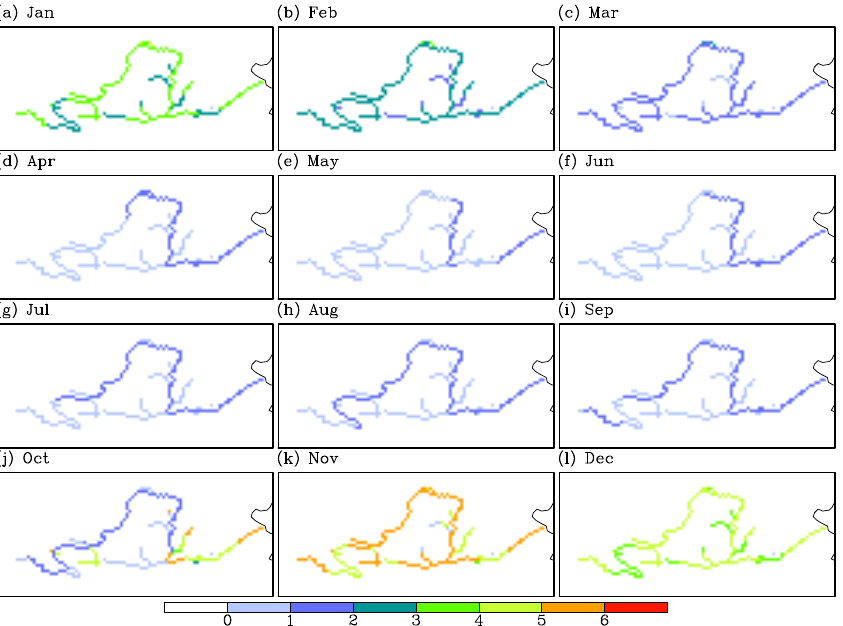
Figure 8. Maximum lead time (months) where the initial conditions prevail over the meteorological forcings (RMSE ESP /RMSE revESP < 1) in the streamflow predictability.